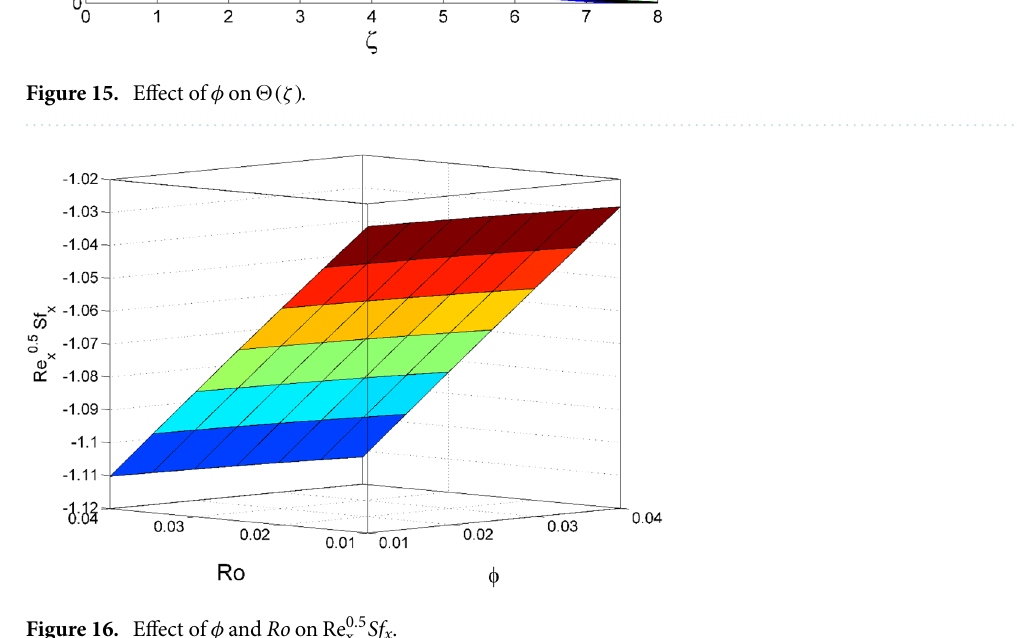
Figure 16. Effect of φ and Ro on Re 0.5 x Sf x .